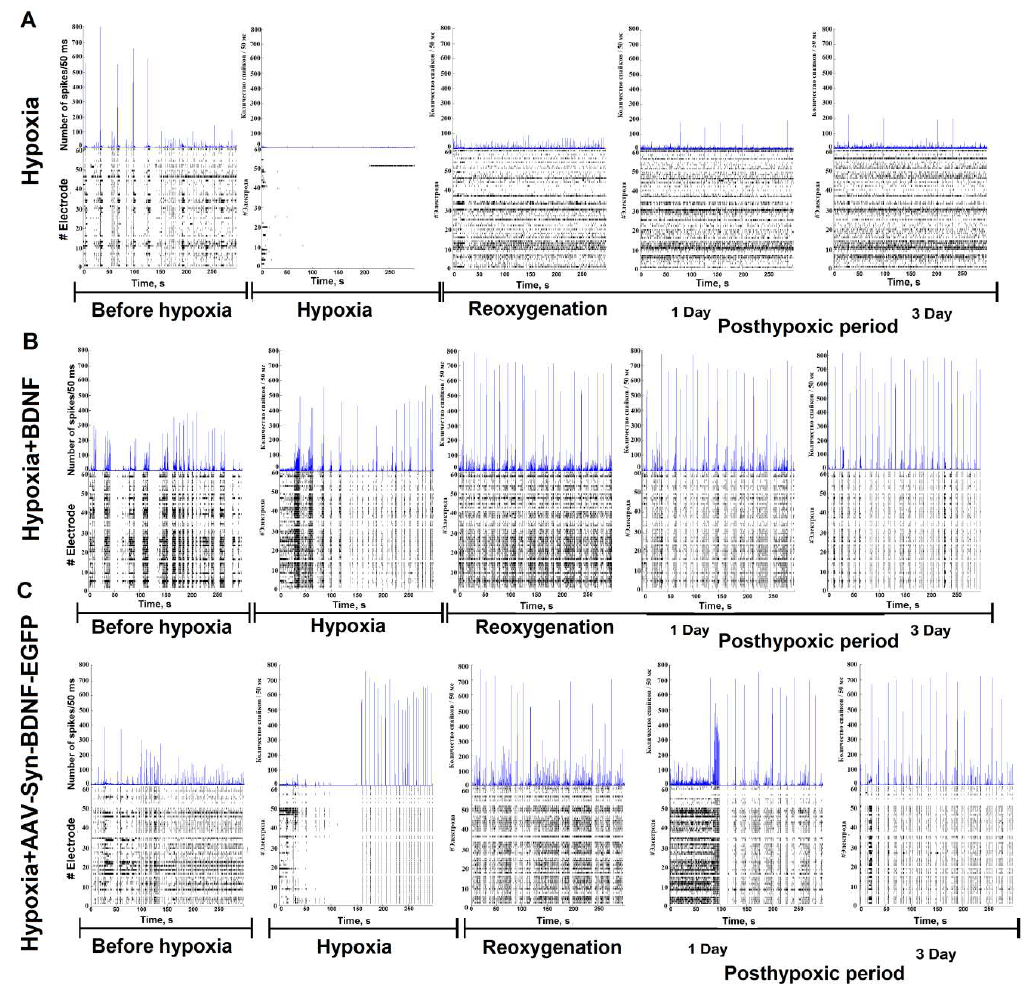
Figure 5. Number of spikes/50 ms and raster diagrams of spontaneous bioelectrical activity in primary hippocampal cultures during hypoxia and in the posthypoxic period: A —hypoxia, B —hypoxia + BDNF, C —hypoxia + AAV-Syn-BDNF-EGFP.